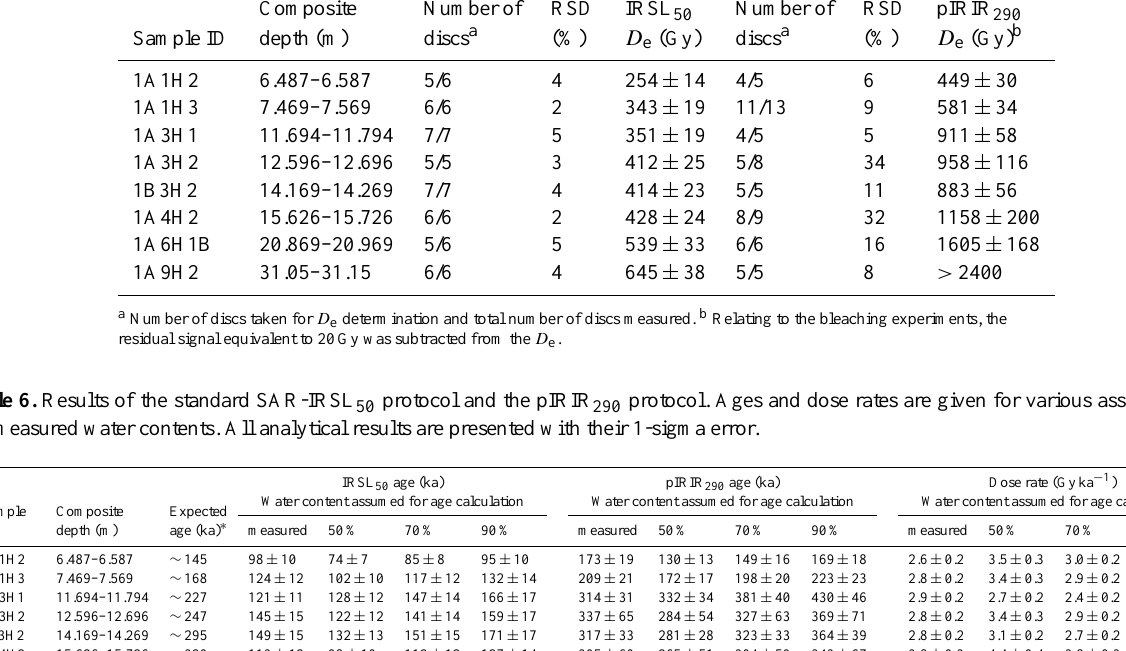
Table 5. Equivalent doses obtained for the standard SAR-IRSL 50 protocol and the pIRIR 290 protocol. Composite Number of RSD IRSL 50 Number of RSD pIRIR 290 Sample ID depth (m) discs a (%)